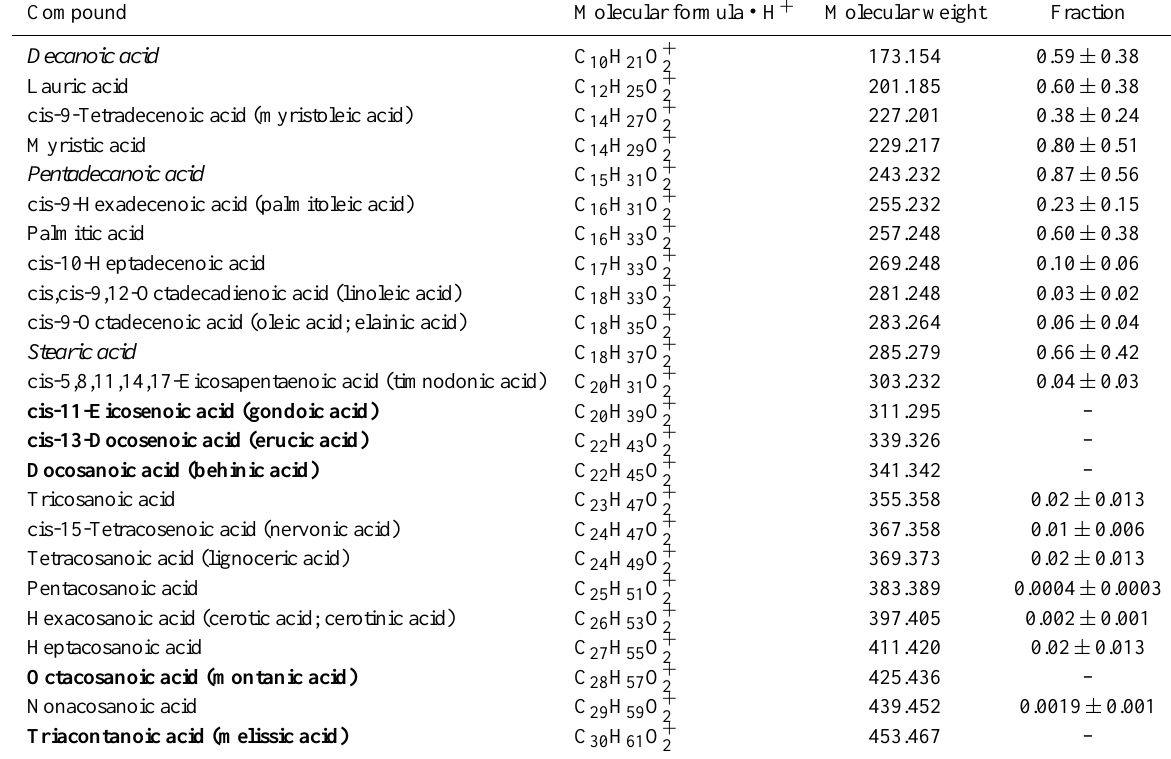
Table 1. Molecular formula, masses, and fraction recovered of 24 protonated monocarboxylic acids measured as standards on quartz filters individually (in italic) and in the multicomponent mixture. Acids indicated in bold are not detected with the offline TD-PTR-MS technique.